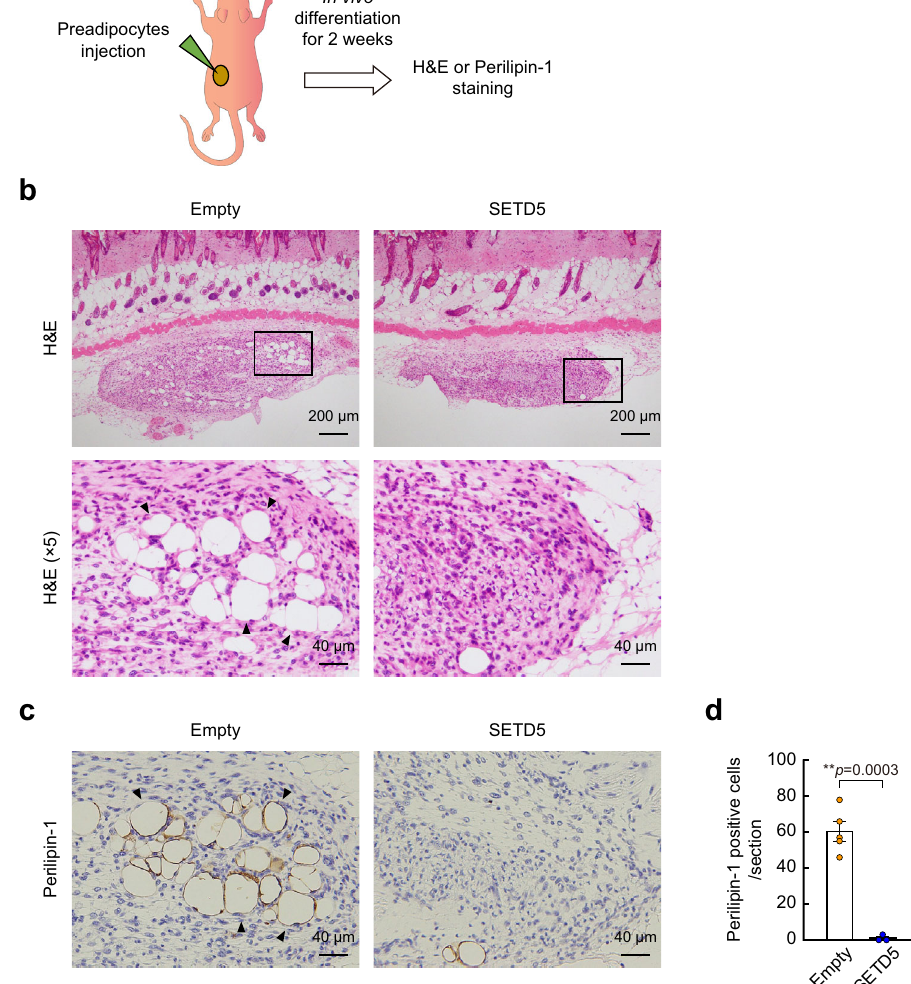
Fig. 7 SETD5 inhibits adipogenesis in vivo. a Transplantation of 3T3-L1 preadipocytes into nude mice. 3T3-L1 preadipocytes transduced with control empty virus or SETD5-V5 were cultured for two days with MDI cocktail. Subsequently, harvested cells were implanted with HydroMatrix and injected into the subcutaneous region on the upper or lower back of nude mice. b, c Two weeks after transplantation, mice were dissected, and isolated transplanted fats were subjected to haematoxylin and eosin (H&E) staining ( b ) and immunohistochemistry using anti-perilipin-1 antibody ( c ). Representative images of transplants from the lower back are shown. d Quantitation of perilipin-1 positive adipocytes. Data are mean ± SE in the section of transplants from empty virus transduced ( n = 5) or SETD5 transduced ( n = 3) preadipocytes Unpaired two-tailed Student ’ s t -test. ** p < 0.01. Source data are provided as a Source data fi